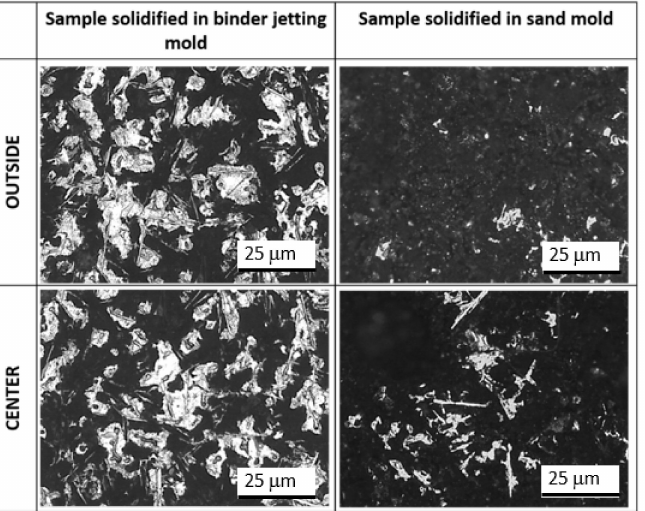
Figure 10. OM micrographs of corroded surface products immersed in 3.5% NaCl solution for the specimen in the binder jetting mold and sand casting